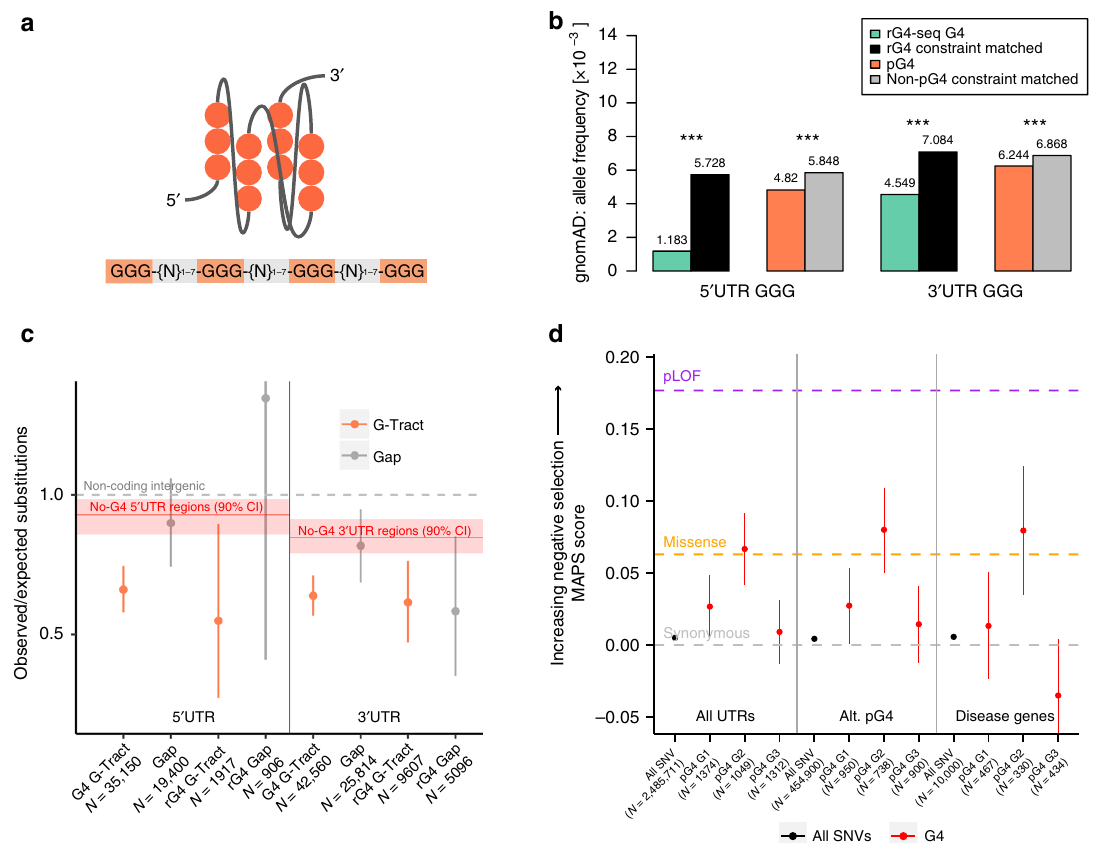
Fig. 1 UTR pG4 sequences are under heightened selective pressure. a Schematic depicting a folded RNA parallel G-quadruplex with the accompanying canonical pG4-sequence. b Reduction in variant frequencies affecting guanine G-tracts within UTR pG4 forming sequences compared to matched non-pG4 G-tracts by transcript-level constraint. rG4-G-tracts are those within UTR pG4 that have evidence of secondary structure formation by rG4-seq. Asterisks denote P value << 2.2 × 10 − 16 by Fisher ’ s exact test. c Reduction in the number of observed polymorphic sites compared to expectation in 5 ′ and 3 ′ UTR pG4 forming G-tracts using a nucleotide substitution model based on local sequence context (permuted P < 1 × 10 − 4 in all G-tracts compared to matched non-pG4 UTR sequences). Error bars represent bootstrapped 90% con fi dence interval for the ratio of observed vs. expected substitutions within each pG4 region. Red line and shaded regions represent the observed vs. expected number of substitutions in non-pG4 UTR sequences matched by transcript-level constraint and 90% con fi dence intervals, respectively. Gray-dashed line represents an expected vs. the observed ratio of 1:1. d Mutability-adjusted proportion of singletons (MAPS) for each set of variants affecting trinucleotide guanines within the meta-pG4 sequence motif. Central position guanines consistently demonstrate the highest MAPS scores (are most constrained) compared to non-pG4 UTR variants (permuted P < 1 × 10 − 4 ) across all contexts. Error bars represent the 5% and 95% bootstrap permutations for each variant class. Purple-dashed line, orange dashed line, and gray-dashed line represent MAPS score for Ensembl predicted high-impact coding (predicted loss-of-function), missense, and synonymous mutations respectively. Source data for b – d are provided as a Source Data